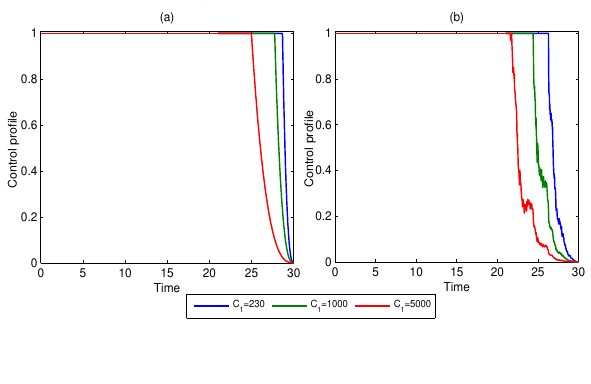
Figure 8. Simulation of control pro- file for different values of C 1